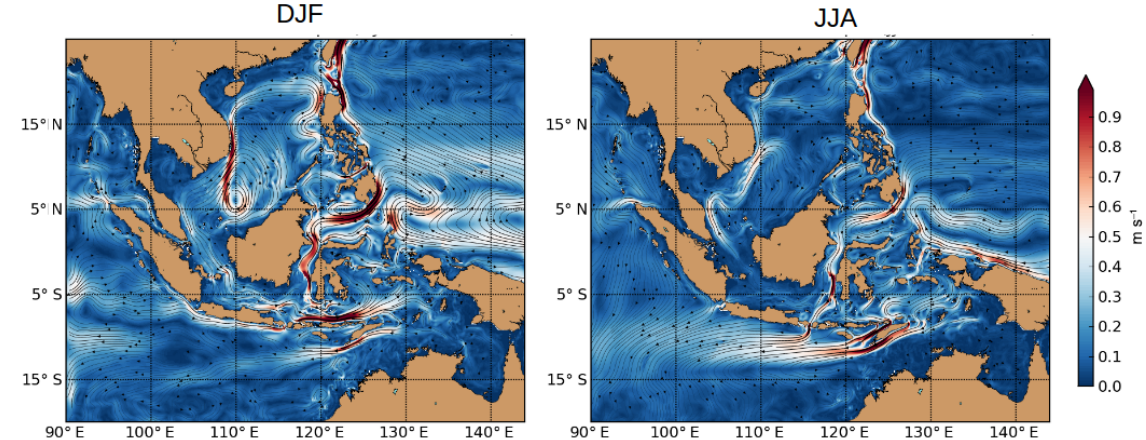
Figure 2. Mean circulation at surface (16m depth) during boreal winter or DJF (left) and boreal summer or JJA (right) during the 2008–2013